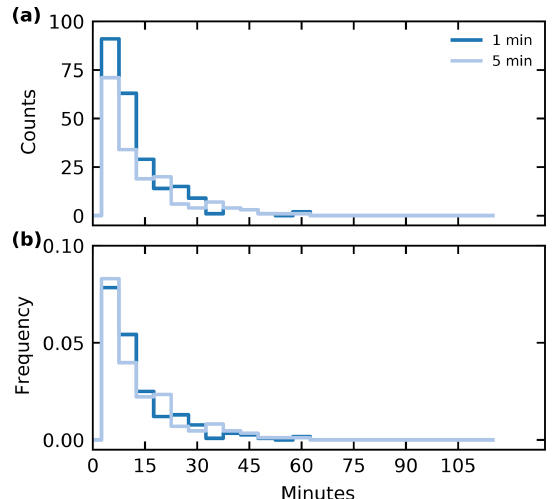
Figure 6. Cell lifetimes for tracking and analysis using two different output time steps (1 and 5min) showing both total counts (a) and the probability distribution function (PDF) (b)